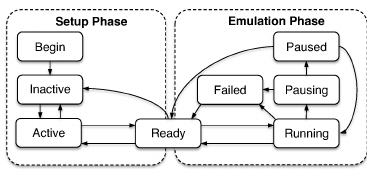
Figure 5: State machine of a devel